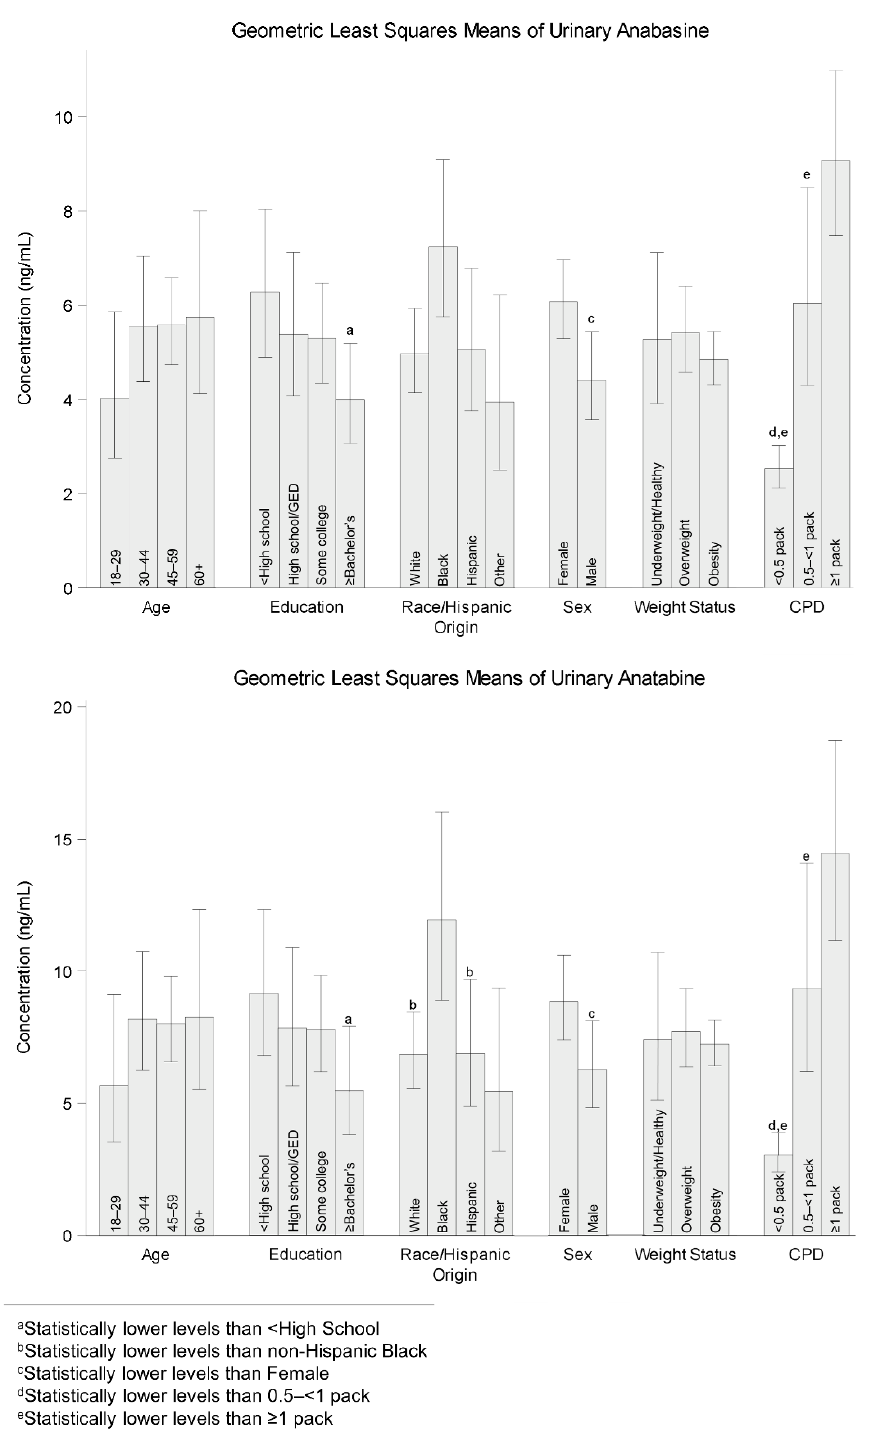
Figure 2. Geometric least squares means and 95% confidence intervals of urinary anabasine and anatabine by demographic characteristics. Geometric least squares means and p -values were calcu- lated from natural log-transformed biomarker concentrations.